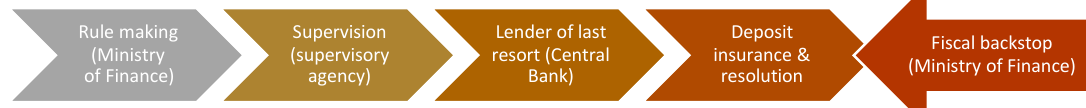
Source: Schoenmaker